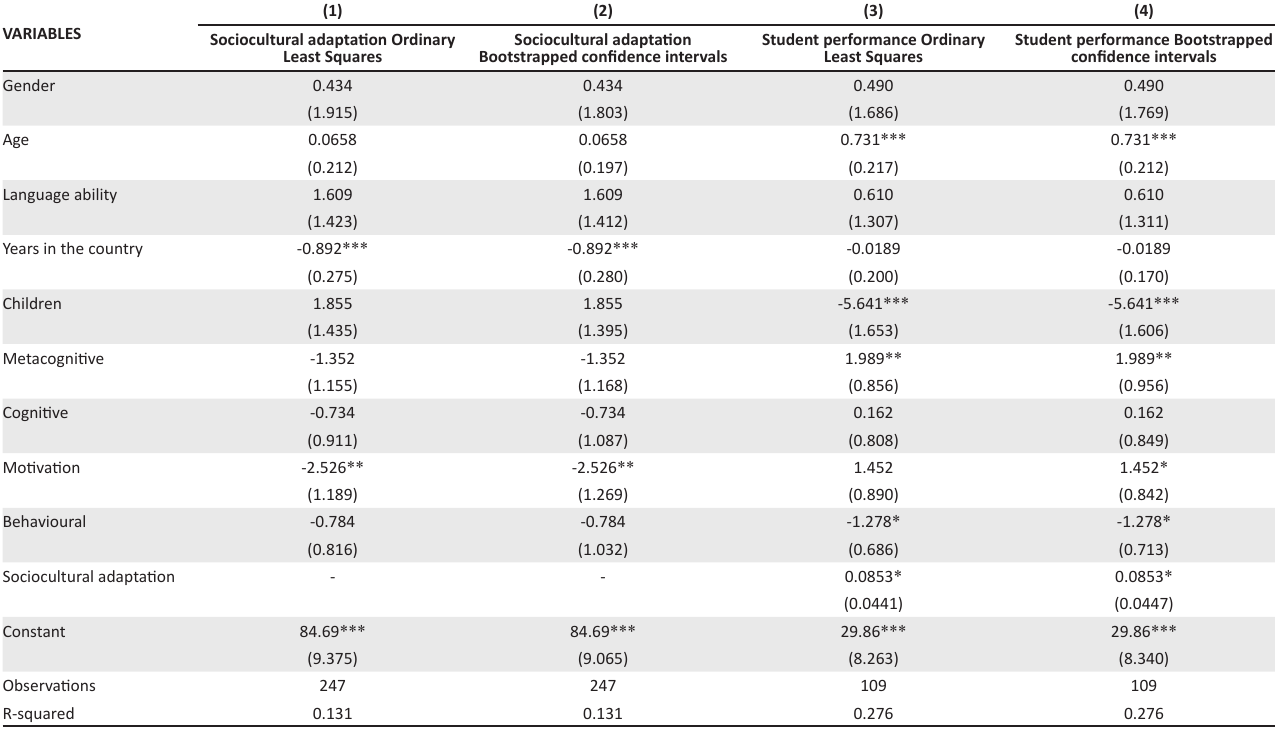
TABLE 3: Determinants of sociocultural adaptation and performance.